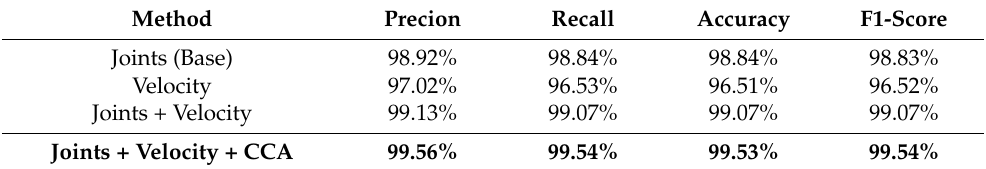
Table 2. Performance evaluation of the proposed HAR method on the UTD-MHAD dataset.